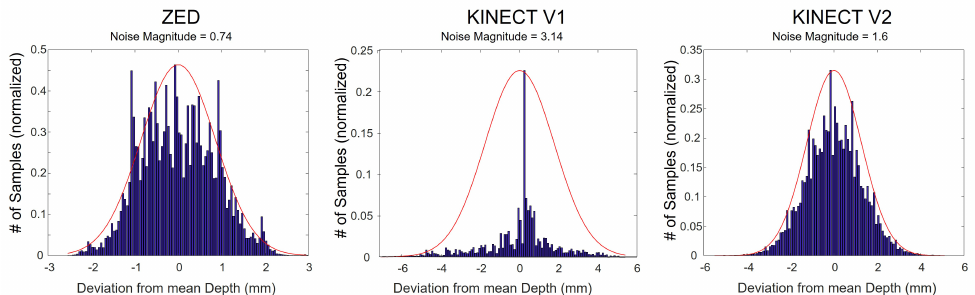
Figure 8. Histograms of deviations from the average depth value of an object at distance 1200 mm from the camera as captured by three types of cameras. Noise magnitude of these examples are (left to right) ZED 0.74, KinectV1 3.14 and KinectV2 1.6 (mm). The noise pattern differ between cameras. (Note the difference in scale of each plot).